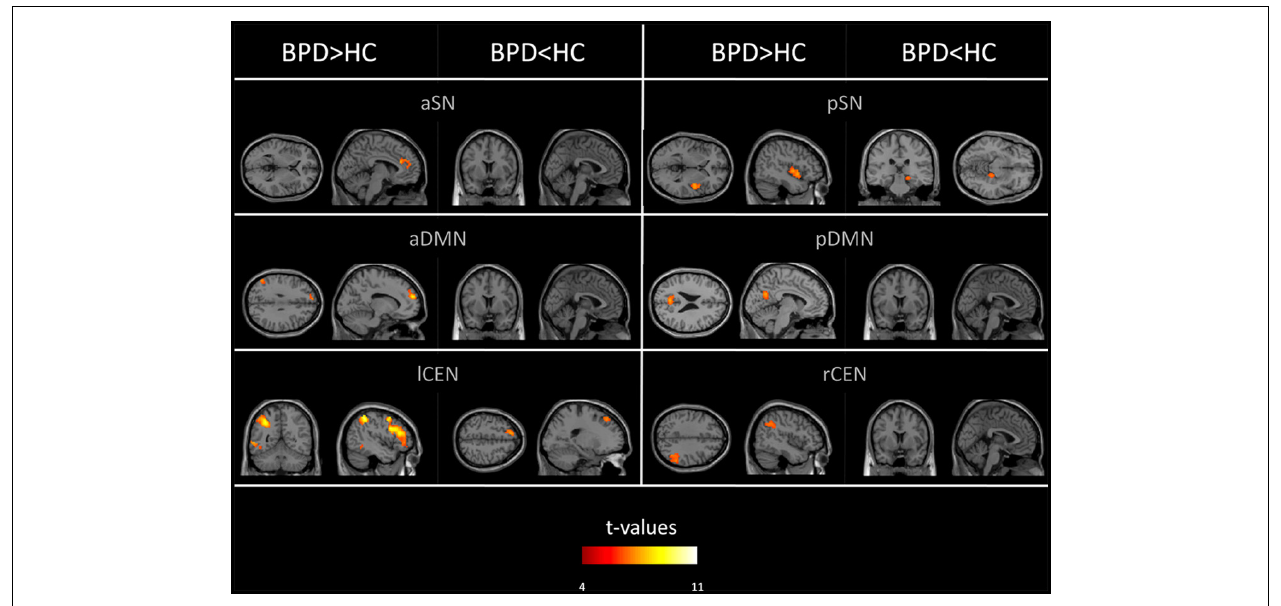
FIGURE 2 |Aberrant intrinsic functional connectivity within DMN, SN, and CEN (intra-iFC) of patients. SPMs of group differences in intra-iFC for the DMN, SN, and CEN (voxel-wise two-sample t -tests) controlled for